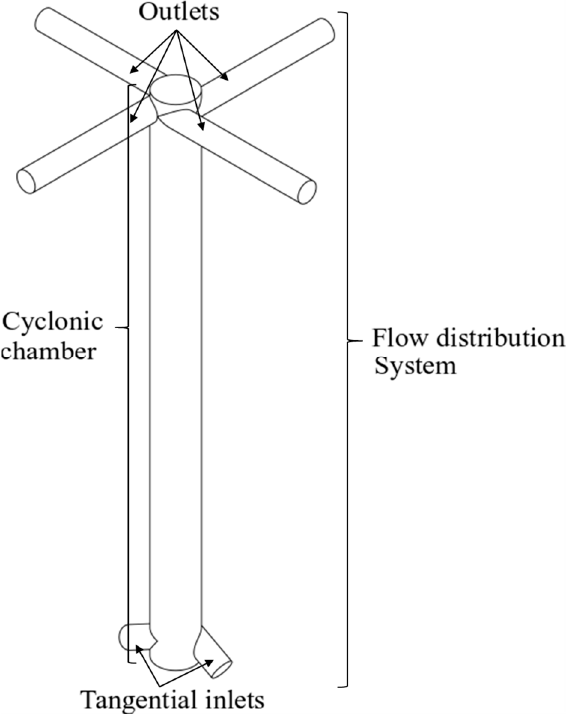
Figure 1. Schematic representation of the flow distribution system.